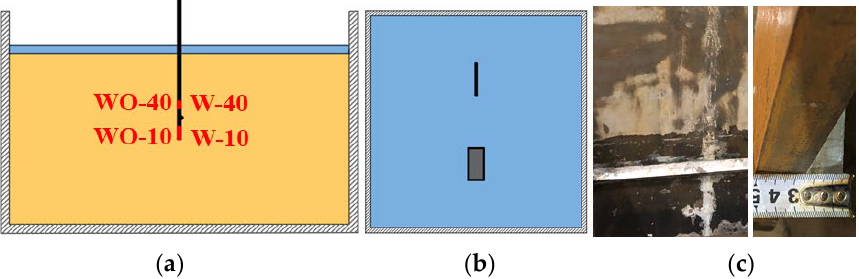
Figure 6. Schematic diagram of the drag-reduction test model and sensor arrangement: ( a ) Elevation; ( b ) Platform; ( c ) Anti-drag ring dimensions.